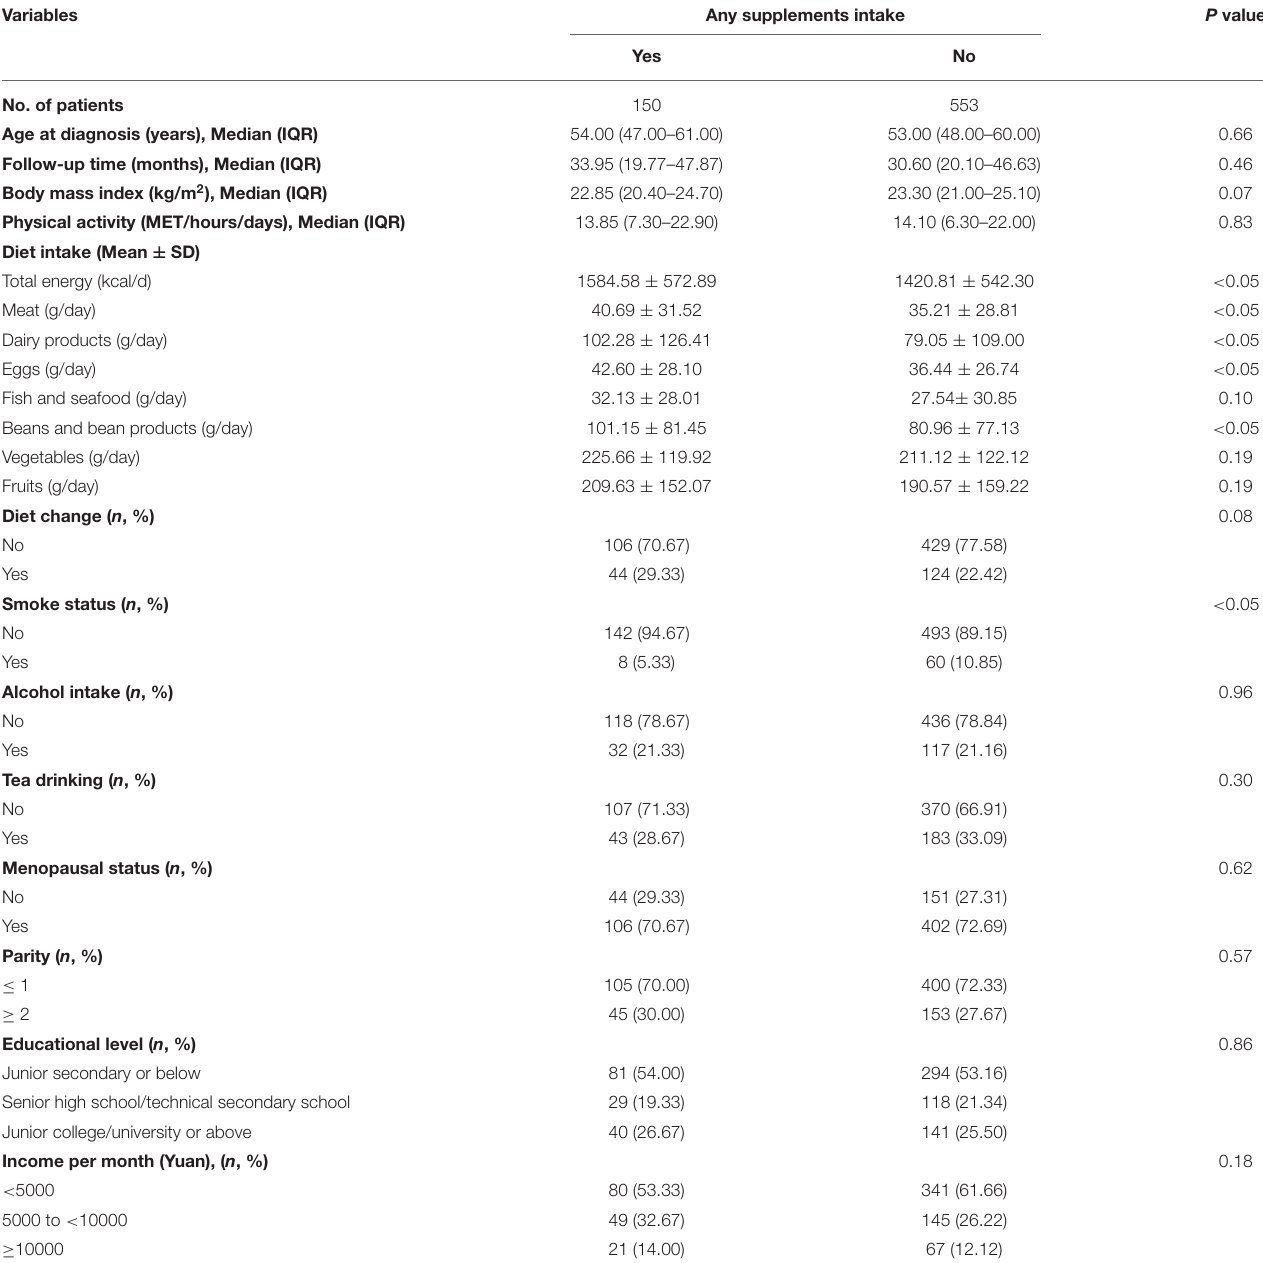
TABLE 1 | General characteristics of patients with ovarian cancer (OC) according to dietary supplements intake ( N = 703).